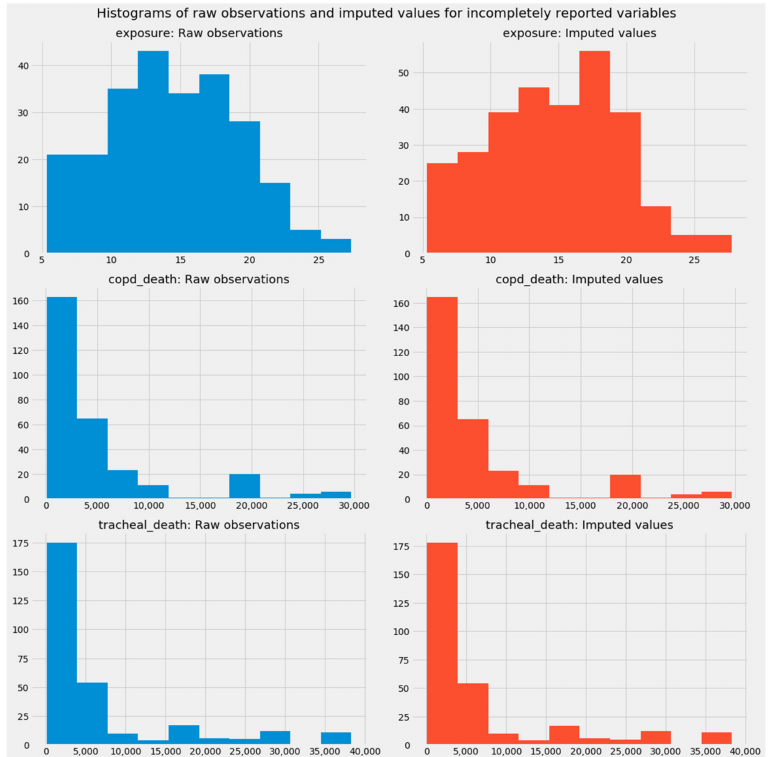
Figure A2. A before-and-after comparison of imputed data series: Histograms of raw observations and imputed values for incompletely reported